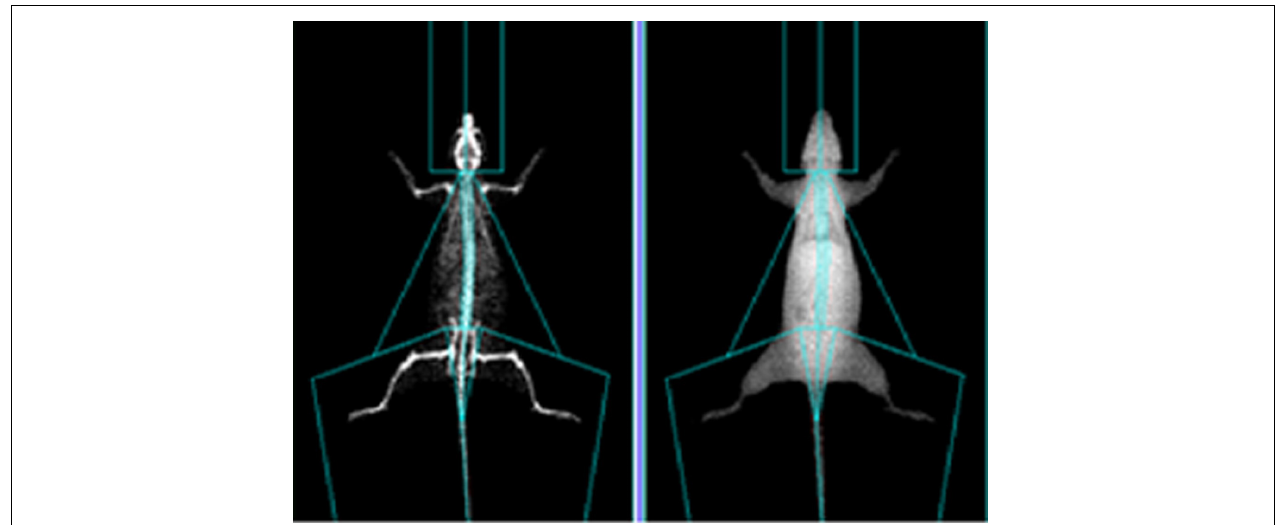
FIGURE 1 | Representative images of DEXA analyses.